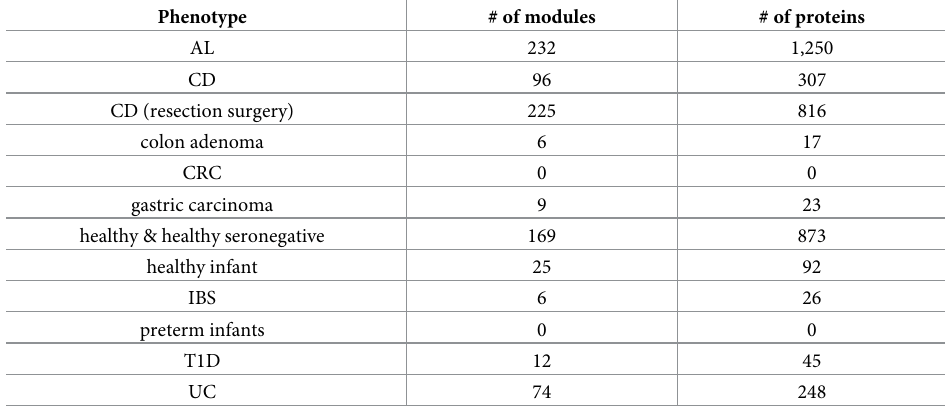
Table 2. Phenotype specific protein co-expression